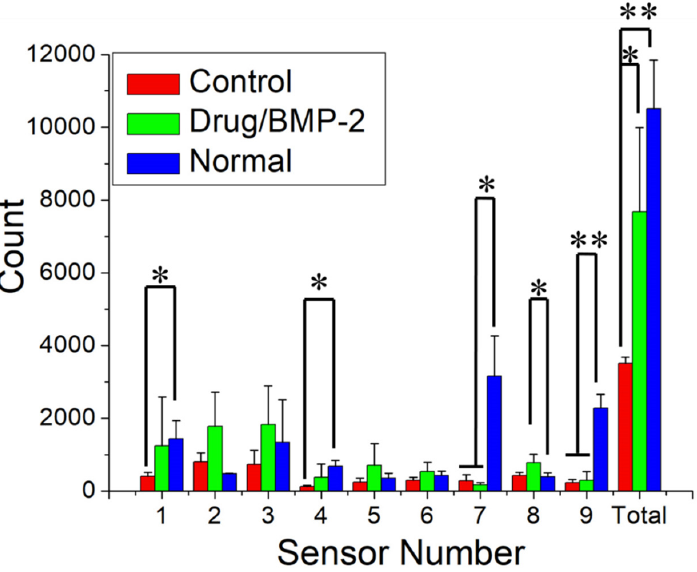
Figure 11. Activity counts when the animals were in a cage for 7 days (* p < 0.05; ** p < 0.01).